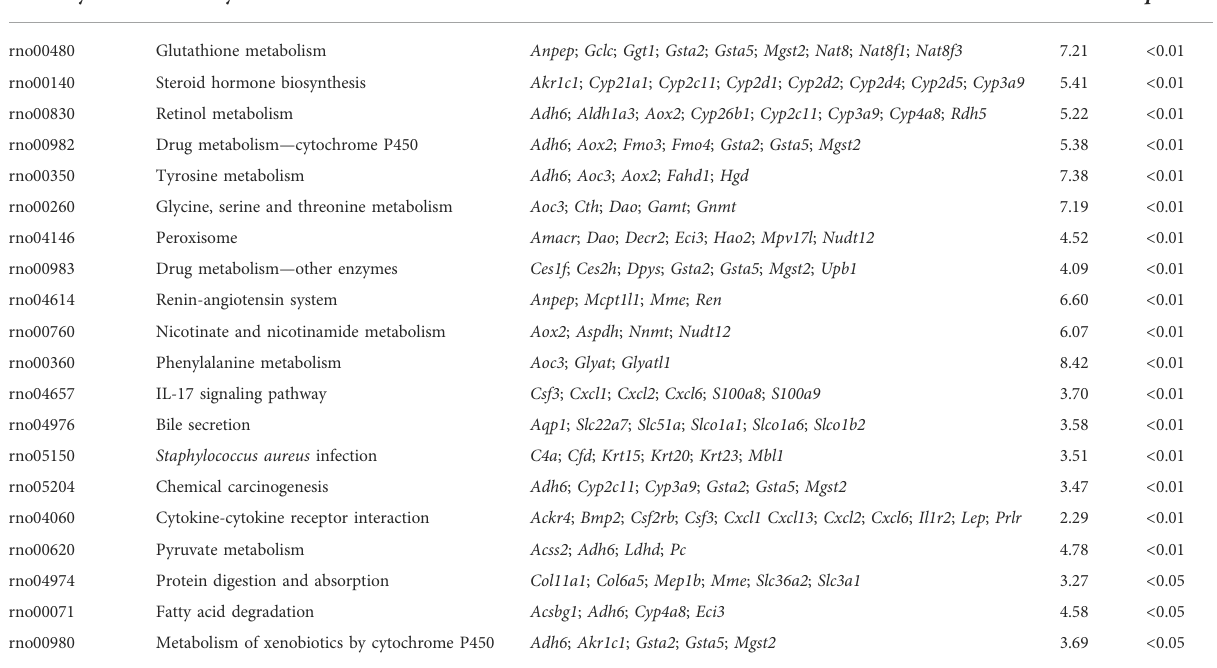
TABLE 2 KEGG pathway enrichment analysis of DEGs (Top